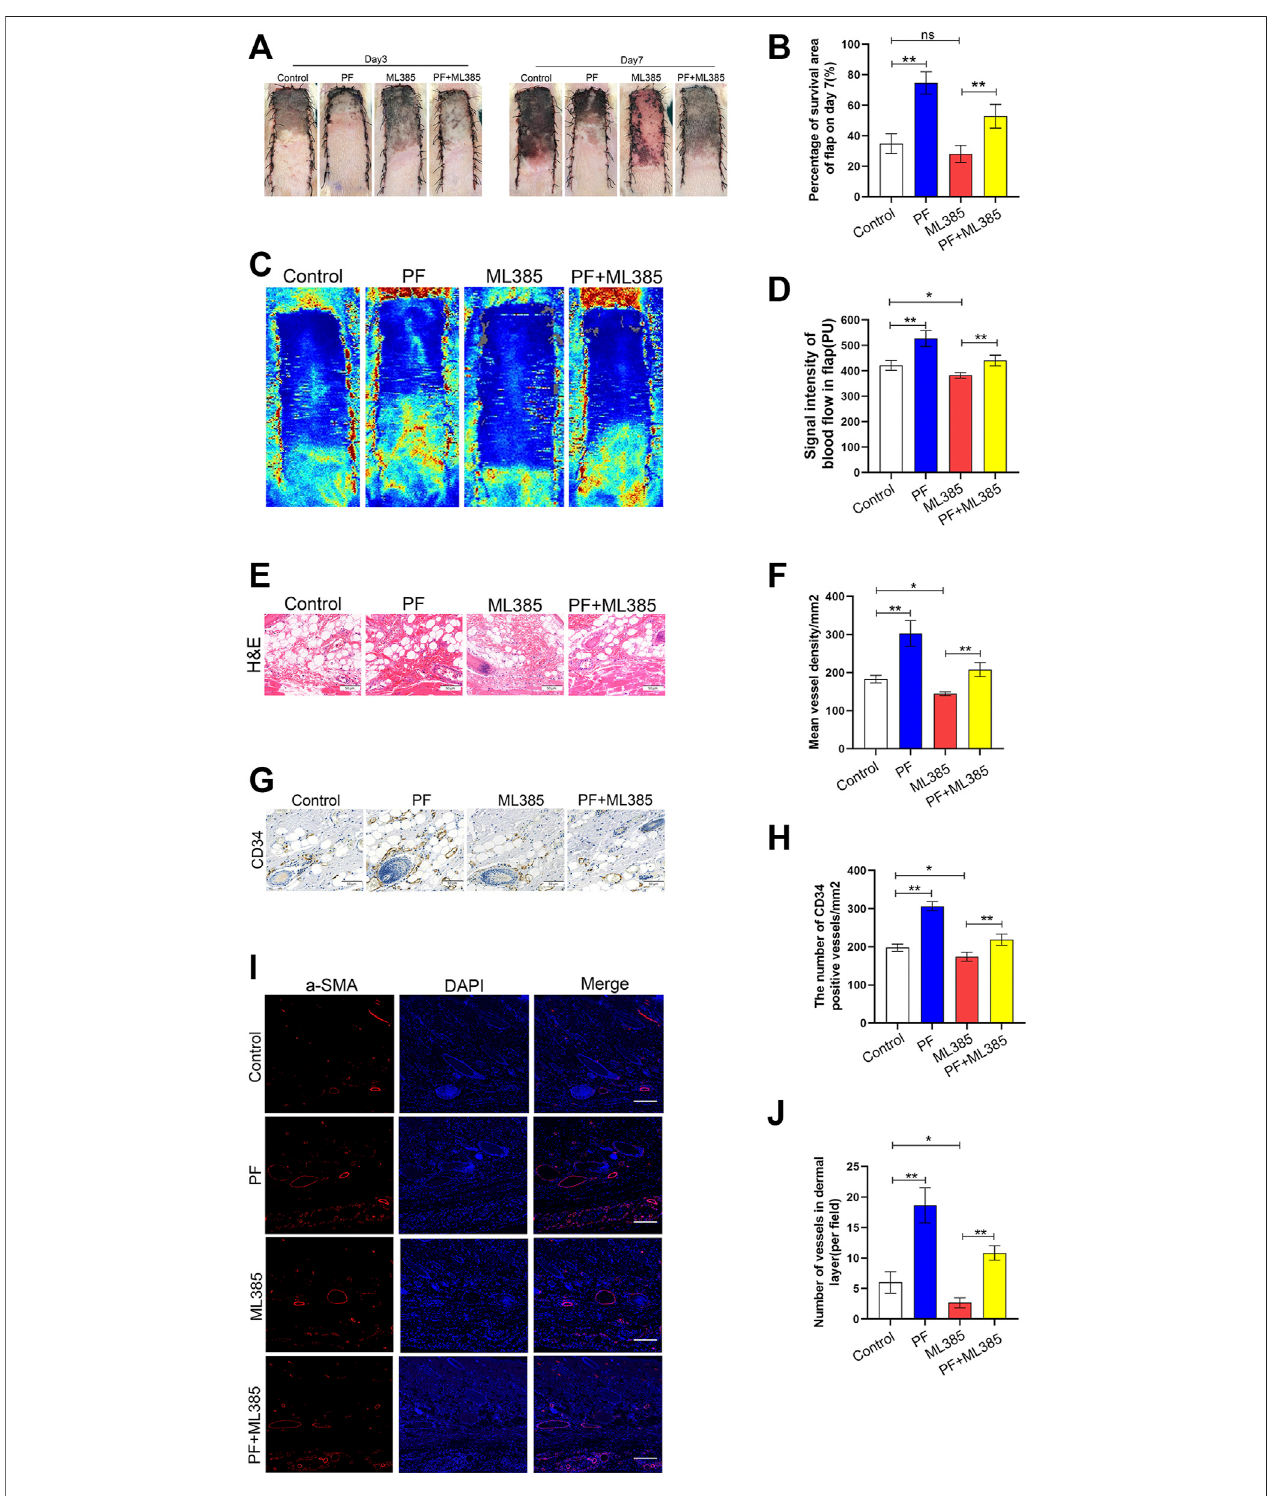
FIGURE7| Paeoni fl orin(PF)enhancesrandom-patternskin fl apssurvivalinrats. (A) Digitalimagesofthesurvival/necroticareafromthreegroupsonPOD3and7. (B) Evaluation of survival area on POD 7. (C) Evaluation of Blood fl ow and vascular distribution by Laser Doppler Blood Flow in each group. (D) Histogram showed the intensity of the blood fl ow signal. (E) Evaluation of CD34 marking vessels in vascular endothelial cells using IHC (200 × ; scan bar, 50 μ m). (F) Evaluation of CD34 + vessel density (%) using histogram. (G) Evaluation ofsubcutaneous blood vesselsand in fl ammation via H&E staining in different groups (200 × ; scan bar, 50 μ m). (H) Flap mean vessel density (MVD) assessment (/mm 2 ) using histogram. (I) Evaluation of a-SMA expressing vessels in vascular endothelial cells, using immuno fl uorescence (200 × ; scan bar, 50 μ m). (J) Quanti fi cation of a-SMA positive vessel density in dermal layer using histogram. Data: mean ± SD, * p < 0.05 and ** p < 0.01. n (cid:2) 6.